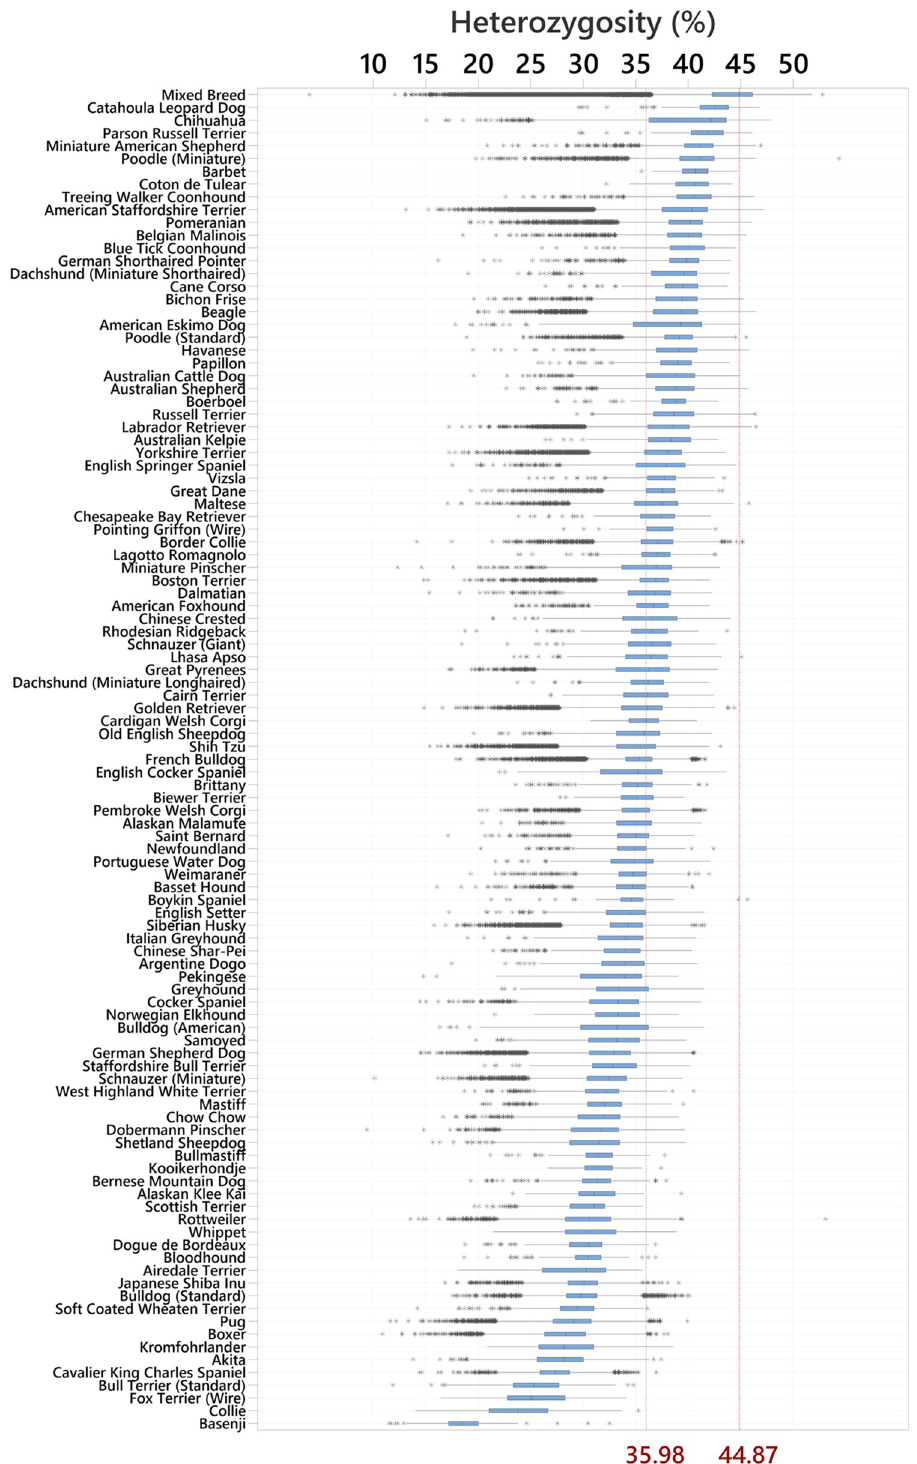
Fig 2. Genome-wide heterozygosity in mixed breed dogs and 104 breeds (N � 100 dogs tested) ranked from most to least diverse. The figure shows medians and interquartile range boxes representing the middle 50% of the data, with whiskers representing the ranges for the bottom and top 25% of the data values excluding outliers (data points > 1.5x the interquartile range from the boxes; shown as asterisks). The red vertical reference lines represent the median heterozygosity in the combined purebred dog group (35.98%) and mixed breed dogs (44.87%).